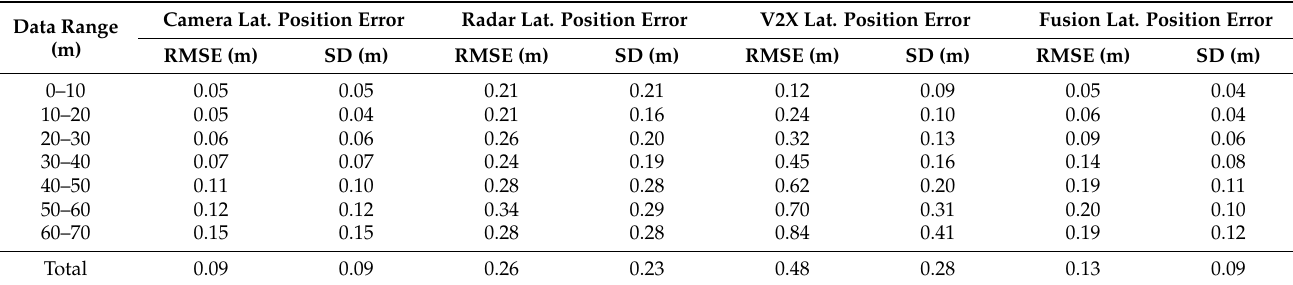
Table 8. Relative positioning accuracy in the lateral direction for the measurements obtained during the normal driving scenario 1. Camera Lat. Position Data Range (m)